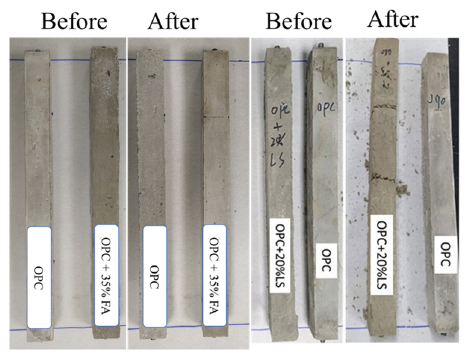
Figure 6. Cement pastes with ladle slag and with fly ash before and after the autoclave expansion test.